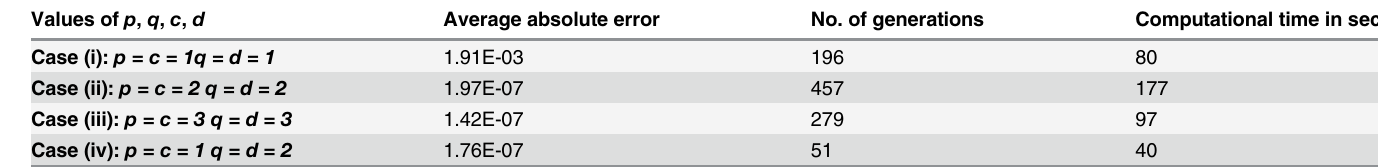
Table 15. Effect of change in c and d on the accuracy and computational time of the proposed scheme. Values of p , q , c ,